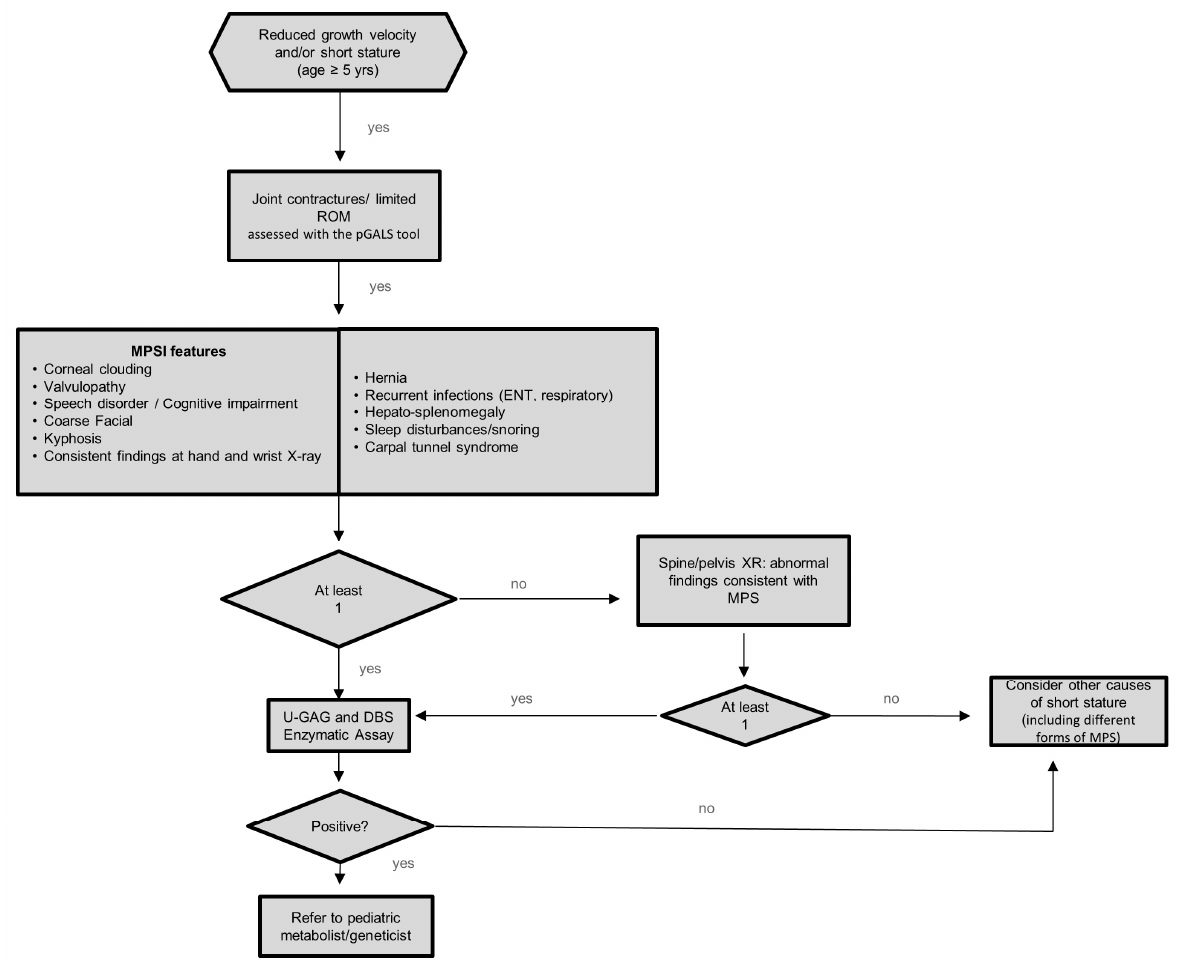
Figure 2. Algorithm for identification of MPS Ia in children with short stature and/or impaired growth. pGALS: pediatric Gait, Arms, Legs, and Spine. ROM: range of motion; DBS: dried blood spot; MPS: mucopolysaccharidosis; GAG: gly- cosaminoglycan; ENT: ear, nose,